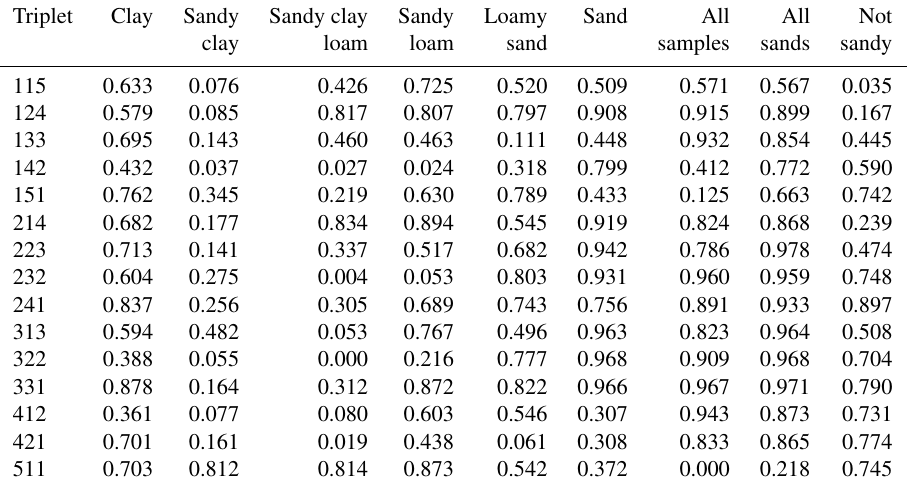
Table 3. Determination of coefficients of regression for the average information entropy versus average bulk density for 10 average entropy